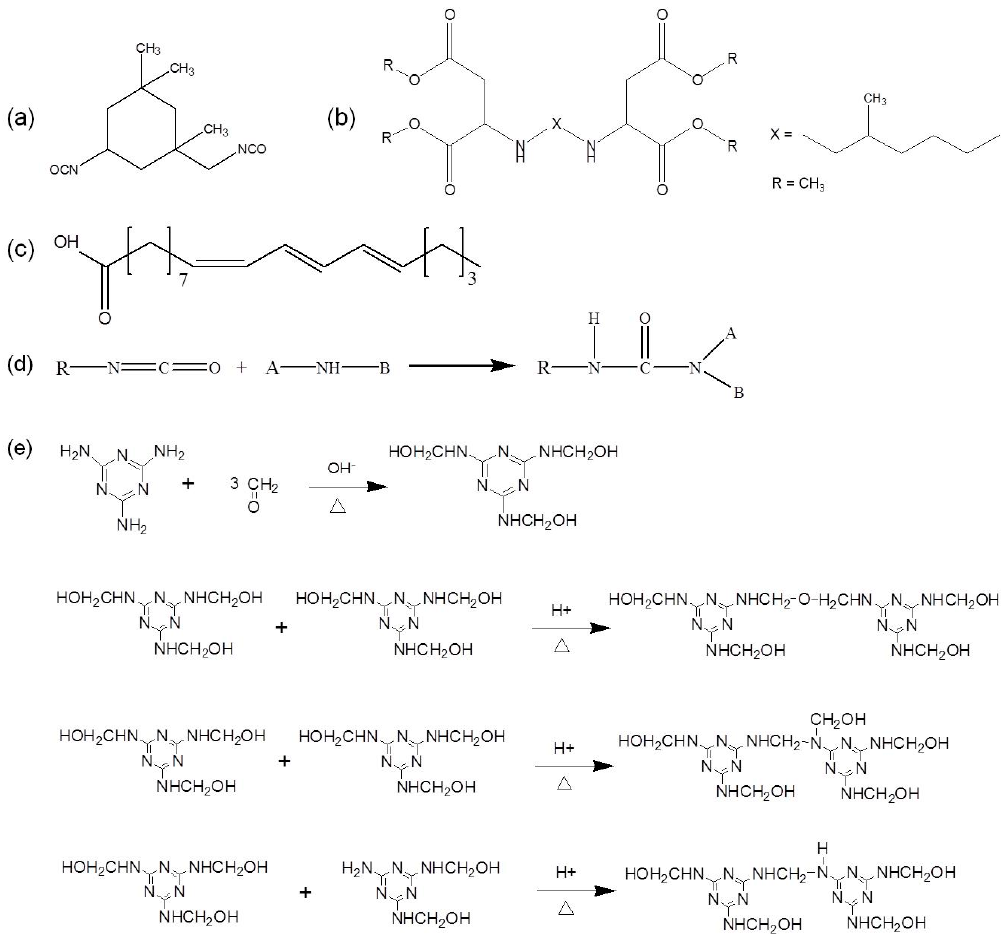
Figure 1. Chemical structure of ( a ) IPDI, ( b ) PAE and ( c ) alpha-eleostearic acid (primary component of TO); ( d ) reaction formula between –NH and –NCO, ( e ) polycondensation reaction of MF prepolymers.